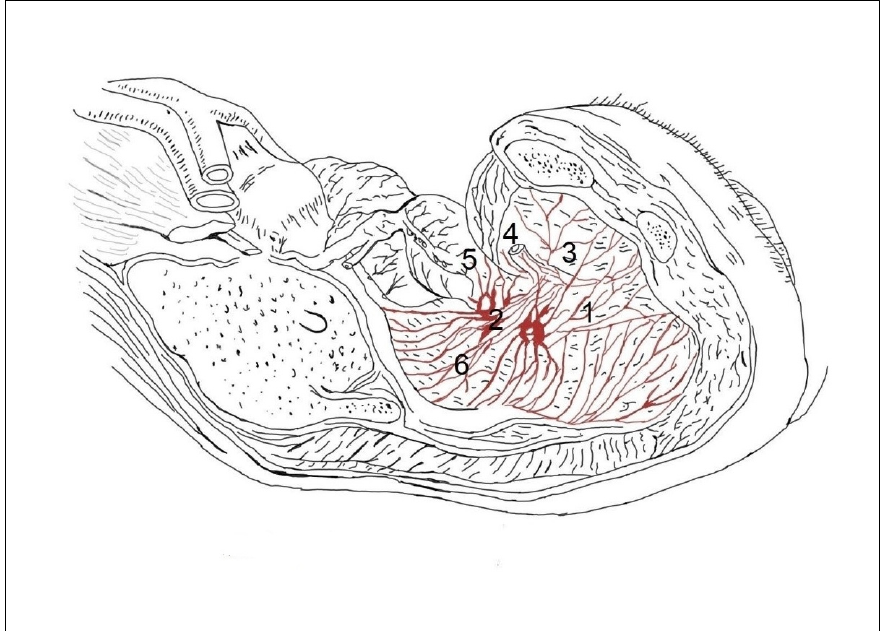
Figure 4. Innervation of lesser pelvis organs in women. In the segmental type, the uterovaginal plexus is formed from the small ganglia (2), from which arise separated branches to the outer surface of the vagina (1), to the urinary bladder (3), ureter (4), vagina (5), uterus (6), and rectum (7).